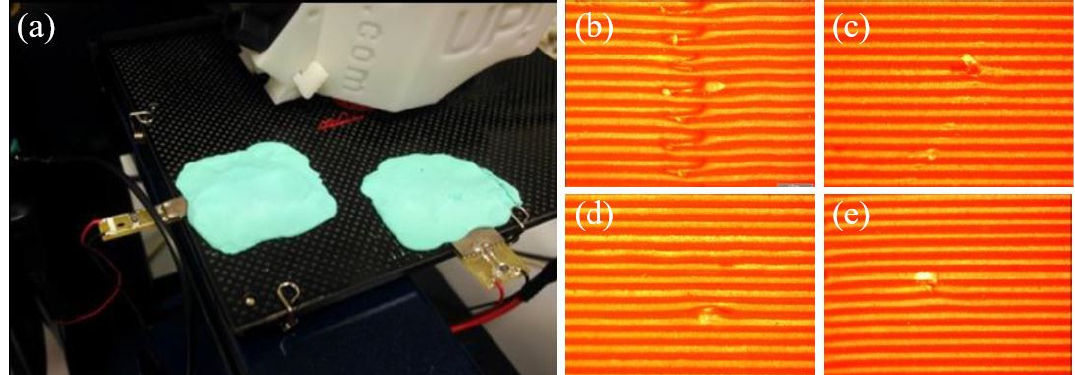
Figure 21. ( a ) Ultrasonic transducers mounted to the printing platform. ( b ) Surface of the original ABS sample. ( c ) The 11 kHz treated surface. ( d ) The 16 kHz treated surface. ( e ) The 21 kHz treated surface. The quality of the surface finish improves with the increment of the frequency